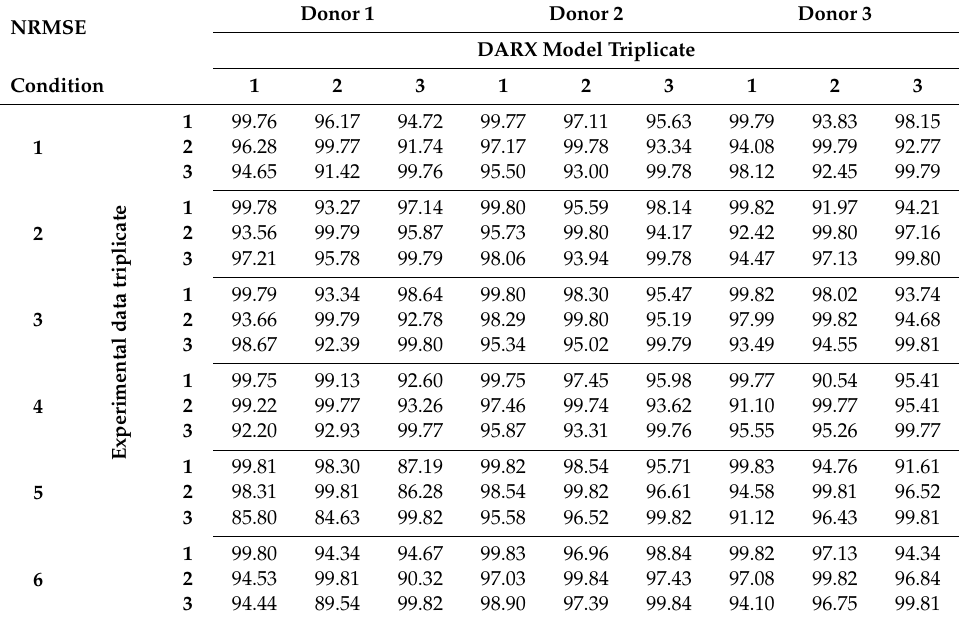
Table 5. Accuracy measured using normalised root mean square error (NRMSE) of DARX model compared to output of the interpolated data for each condition, donor and triplicates. The DARX model used is either the one based on the corresponding experimental data (diagonal values) or on the data of an experimental triplicate. The value is NRMSE multiplied by 100 and expressed as a percentage, with 100 being a perfect fit.